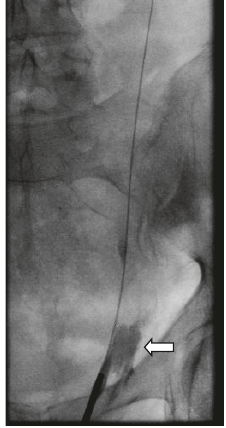
Figure 2: Retrograde contrast application via ureterorenoscope after the misplaced transurethral catheter was removed. The guide- wire previously inserted via Double-J-Stent can be seen in the image’s center. After application of contrast there is a leakage (white arrow) into the retroperitoneal space revealing a ruptured